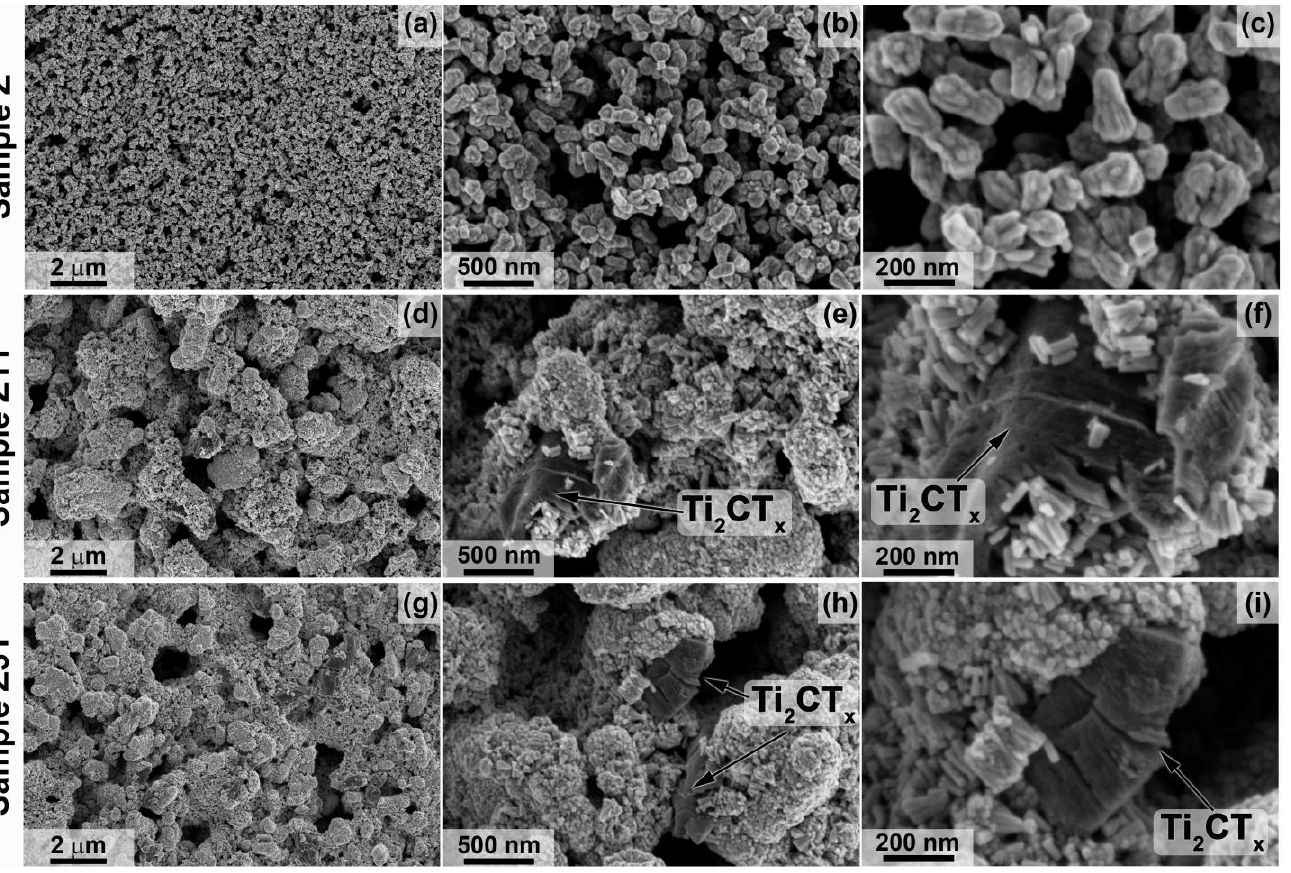
Figure 5. Particle morphology of ZnO/Ti 2 CT x (Z5T) composite powder by TEM.